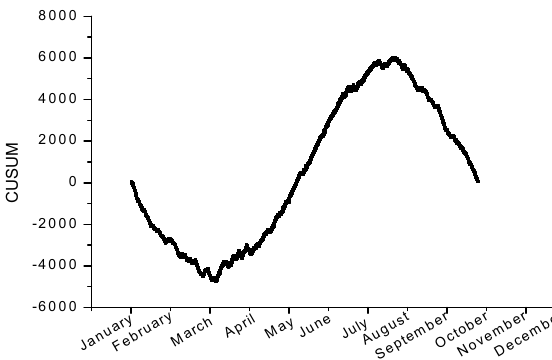
Figure 9. CUSUM chart for original time series data.